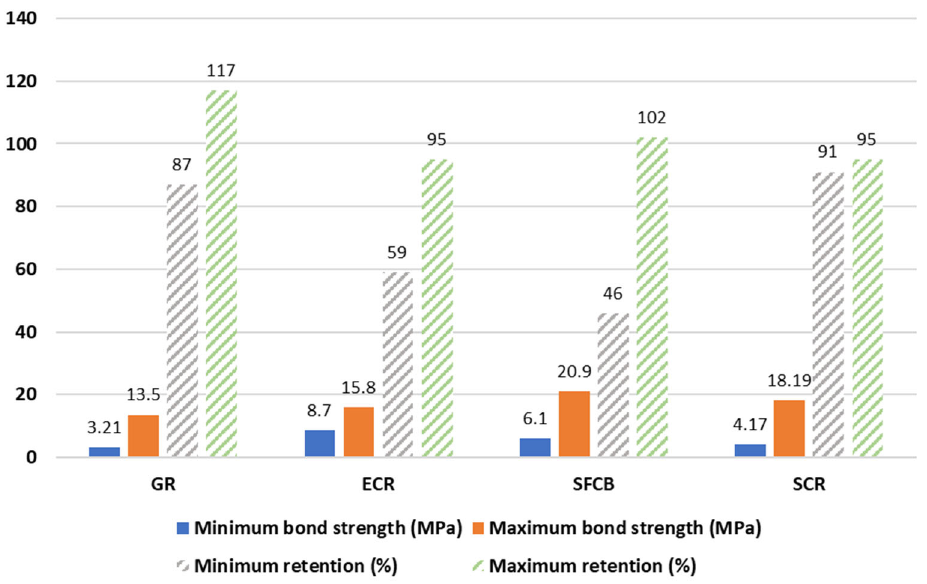
Figure 6. Bond strengths and bond strength retentions due to corrosion [39,94–96,98,102].